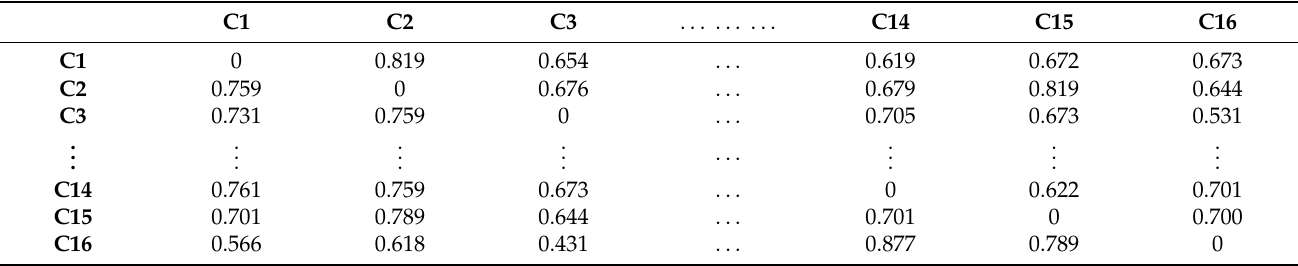
Table 9. Initial direct relationship matrix (A).